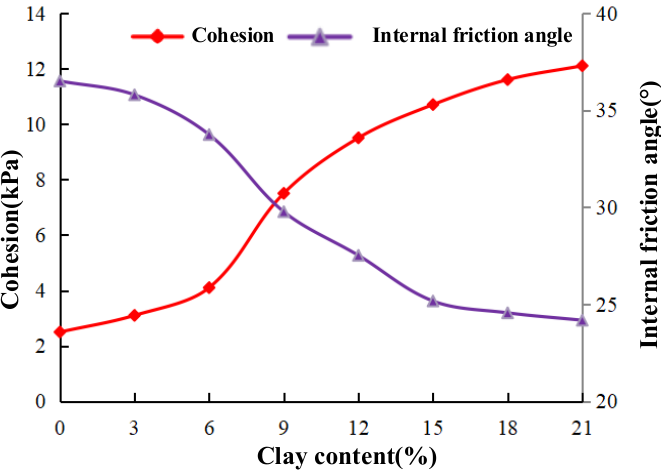
Figure 8. Cohesion and internal friction angle with different clay contents.